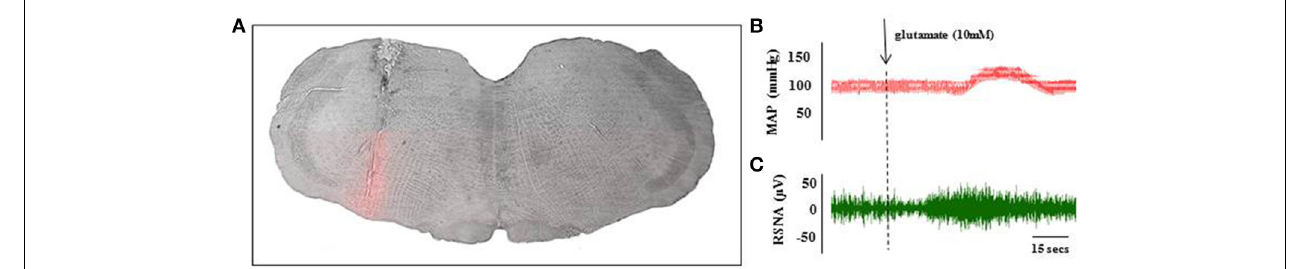
site at the level of the RVLM (A) . Scale bar = 500 microns. Microinjection of glutamate (10mM; 40nL) into the RVLM evoked transient increase in MAP